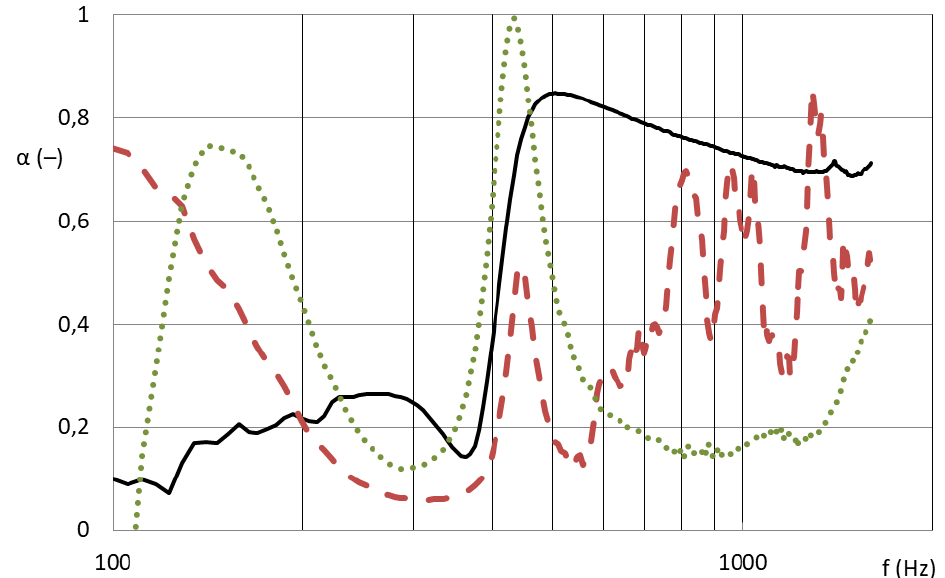
Figure 2. Frequency dependence of the sound absorption coefficient; quad-perforated plate of 9 mm size/11 mm span is covered by a nanofibrous membrane of 0.2 g/m 2 on a carrier of 25 g/m 2 (black line), or foil of 7 g/m 2 (red dashed line), or foil of 40 g/m 2 (green dotted line). The air gap between the 1 mm thick panel and the wall is 50 mm [13].